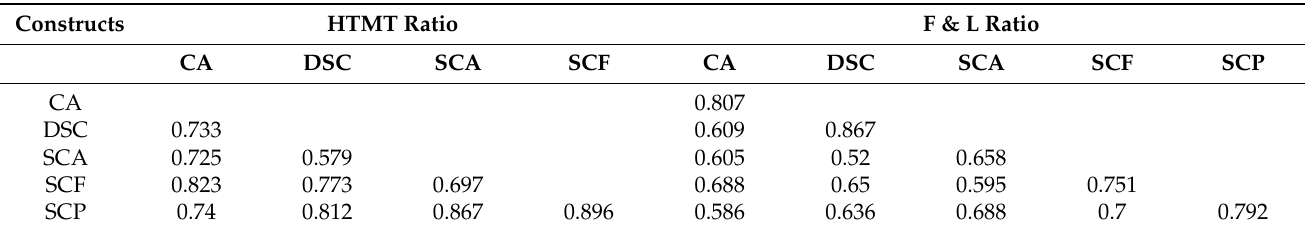
Table 2. Discriminant Validity with